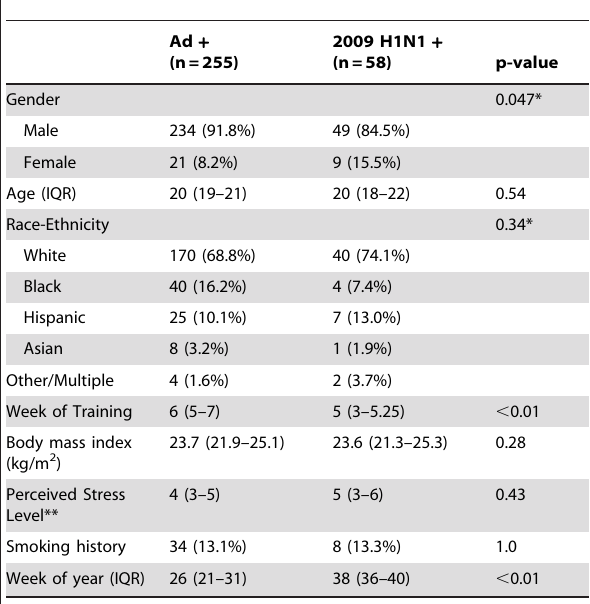
Table 3. Demographic information of trainees presenting with upper respiratory infection and infected with adenovirus (Ad) or 2009 H1N1 alone (n =